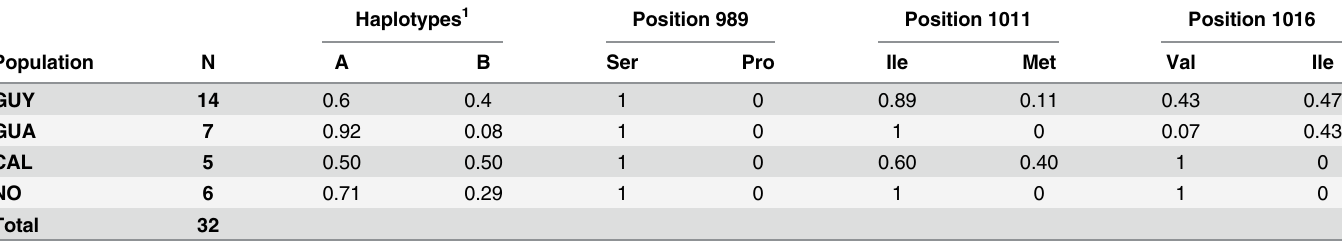
Table 1. characterization of sequences at the Na V gene: number of individuals (N), frequencies of haplotype A and B, allelic frequencies at position 989, 1011 and 1016 of the amino-acid sequence. Ser: Serine, Pro: Proline, Ile: Isoleucine, Met: Methionine, Val: